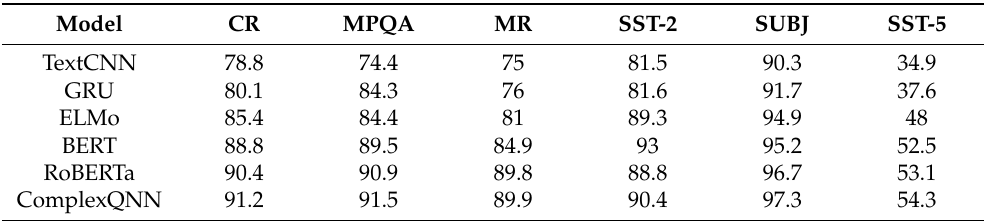
Table 2. Experimental results on six benchmarking sentiment-classification datasets evaluated with accuracy.